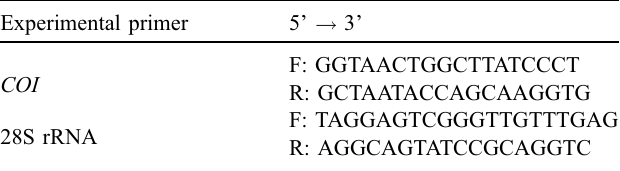
Table 1. Experimental primers used in the study. Experimental primer